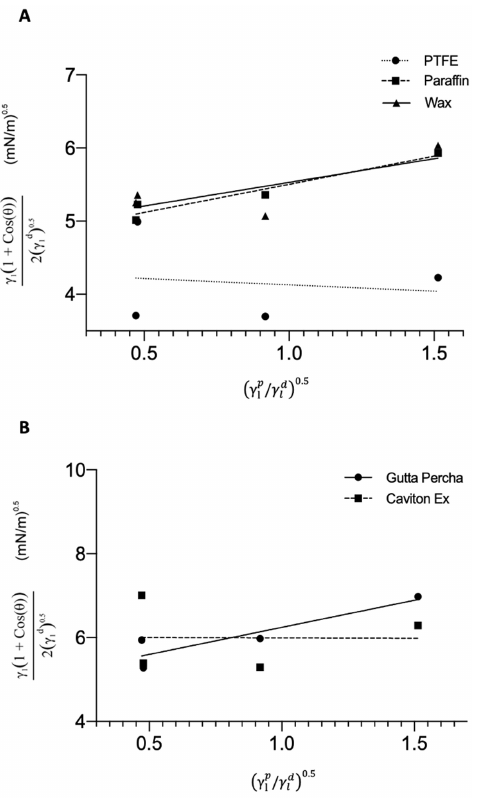
Figure 4. ( A ) Plot of the four liquids against PTFE, PF, and wax. The lines represent the best linear fit to the plotted point, respective to their material. The linear equation was used to solve for m and b to determine the SFE of the respective materials. ( B ) Plot of the four liquids against gutta percha and caviton ex. The lines represent the best linear fit to the plotted point, respective to their material. The linear equation was used to solve for m and b to determine the SFE of the respective